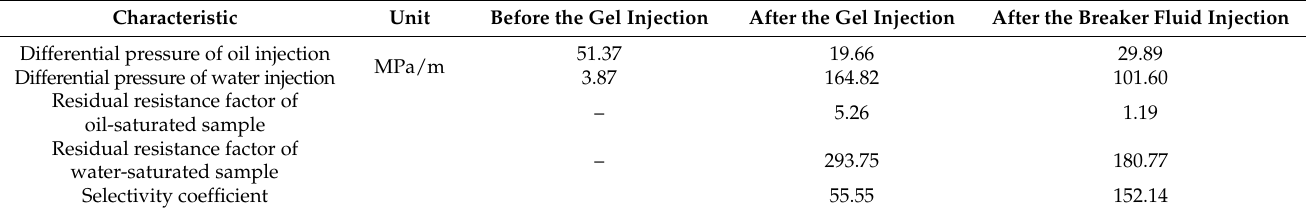
Figure 9. Relation between differential pressure and injected pore volumes of oil and water during the selectivity estimation experiment. Table 5. Results of flooding experiments on selectivity evaluation.